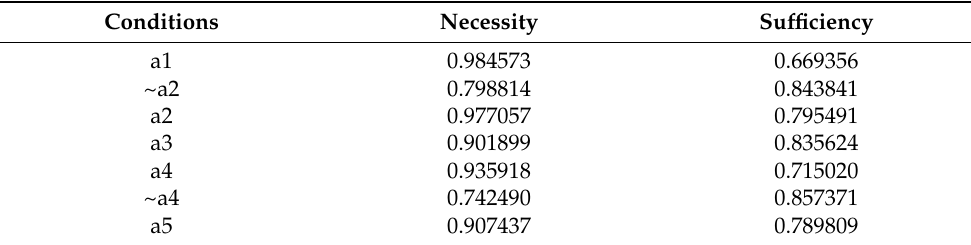
Table A3. Necessity and sufficiency analysis of conditions (outcome A1).